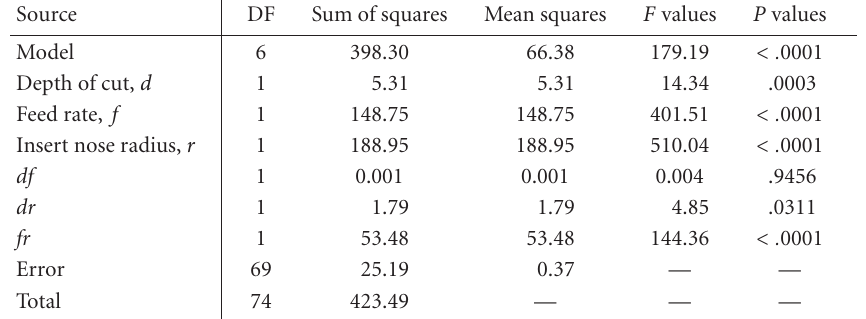
Table 7: Analysis of variance for surface roughness first order and interactions terms model in turning of AISI 1030 using cemented carbide tools.